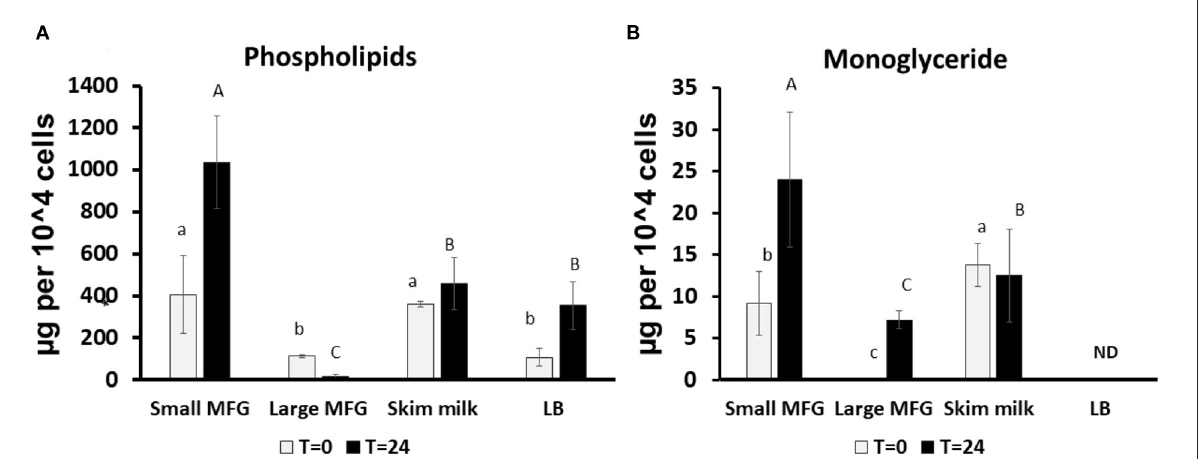
FIGURE3 Changes in lipid profile following incubation of B. subtilis cells with small or large MFG. (A) Quantification of the sum of phospholipids after incubation of B. subtilis with different MFG sizes compared to skim milk or LB broth bacteria substrate. (B) Quantification of MG following incubation of B. subtilis with MFG size fractions compared to skim milk or LB substrate. Lowercase letters indicate significant differences between treatments at t = 0 (white bars; P < 0.05). Uppercase letters indicate significant differences between treatments at t = 24h (black bars; P < 0.05). ND indicated under detectable levels.